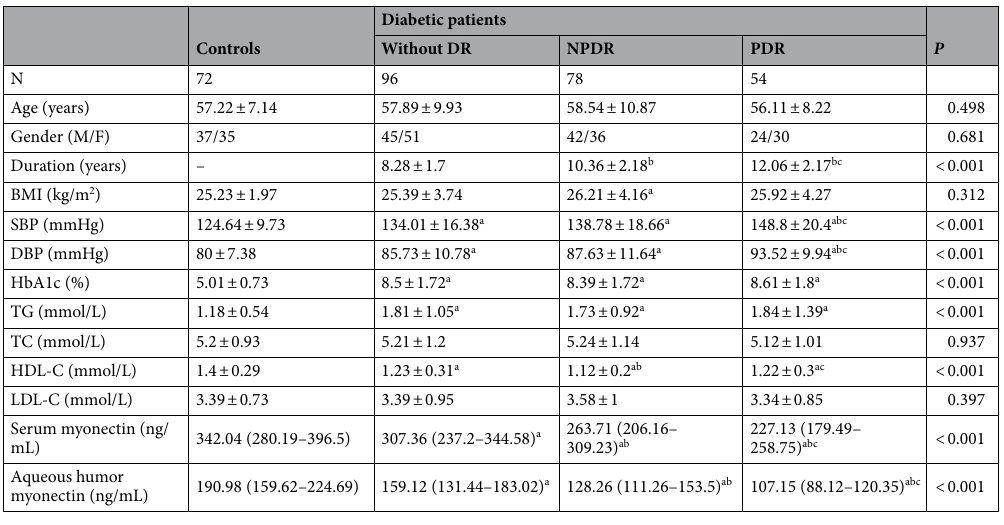
Table 1. Various characteristics of diabetic patients and controls. a P < 0.05 vs. control; b P < 0.05 vs. diabetic patients without DR; c P < 0.05 vs. NPDR patients. BMI body mass index, SBP systolic blood pressure, DBP diastolic blood pressure, TG triglycerides, TC total cholesterol, HDL-C high-density lipoprotein cholesterol, LDL-C low-density lipoprotein cholesterol. The characteristic of gender was analyzed using Chi-square tests. The characteristics of serum and aqueous humor myonectin were analyzed using Kruskal–Wallis test. The other characteristics were analyzed using one-way